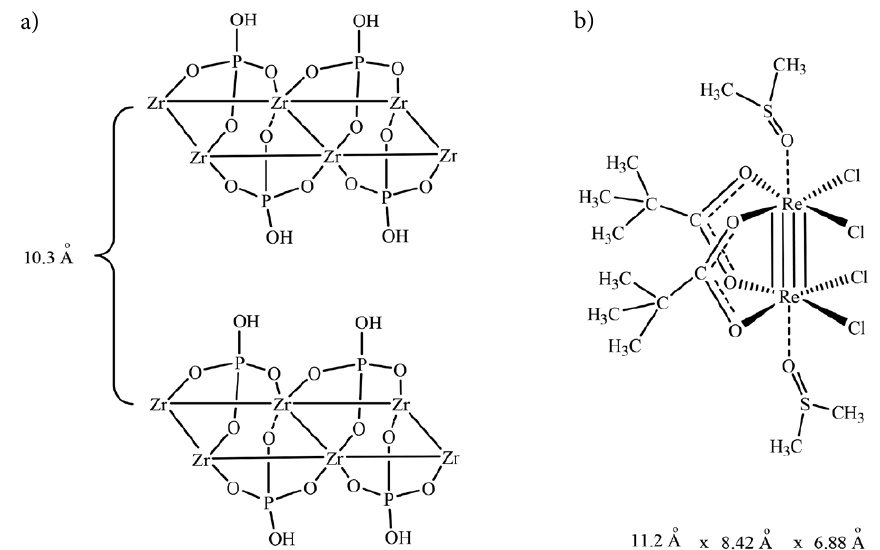
Fig. 1 Structure of Zr(HPO 4 ) 2 · 6H 2 O (θ-ZrP) (a) and cis -Re 2 (C(CH 3 ) 3 COO) 2 Cl 4 · 2DMSO ( I ) (b) with linear